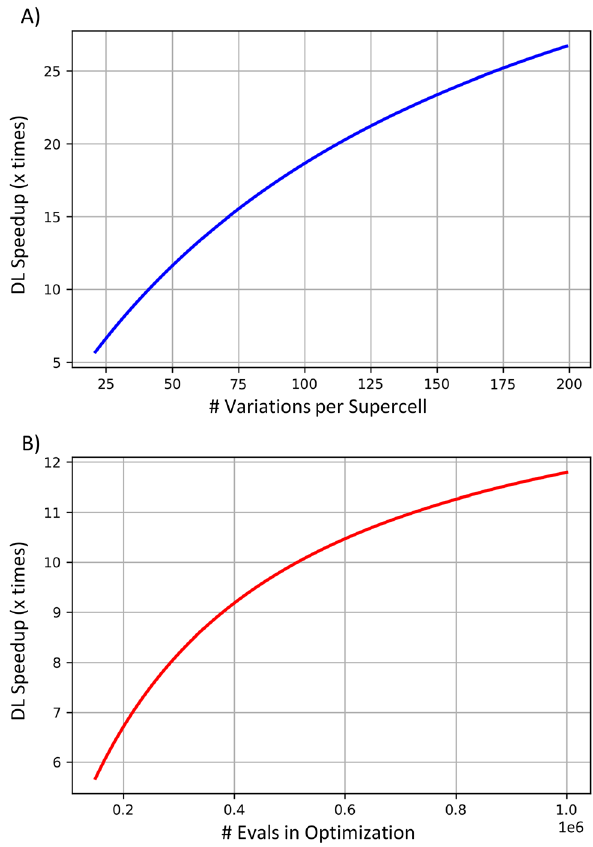
Figure 5: Speedup curves using DL augmentation versus pure full- wave